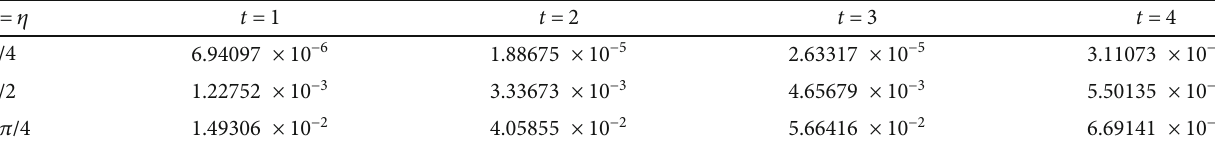
Table 8: The maximum pointwise error at di ff erent times of Example 9.